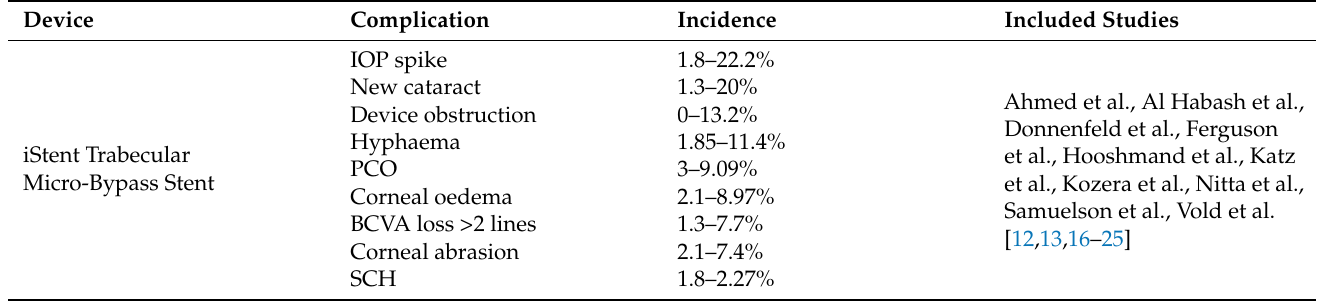
Table A1. Complication Rates of Stents Bypassing the Trabecular